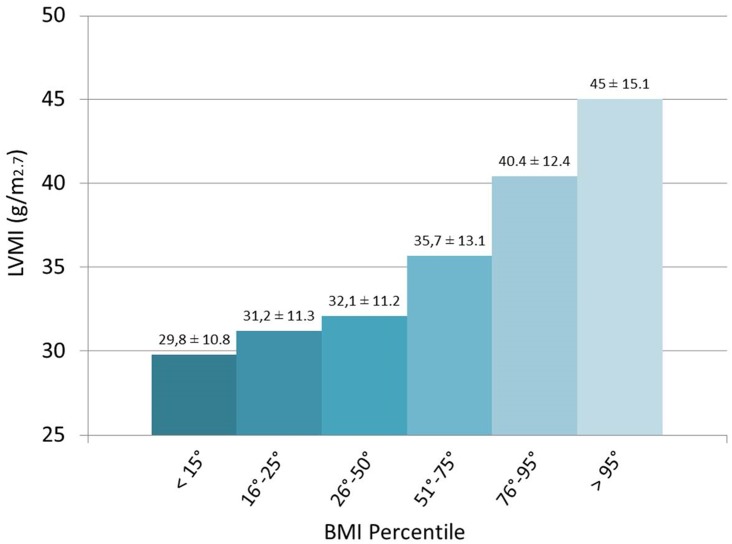
Correlation between LVMI and BMI percentiles.LVMI values decrease in proportion to the reduction of BMI percentiles.